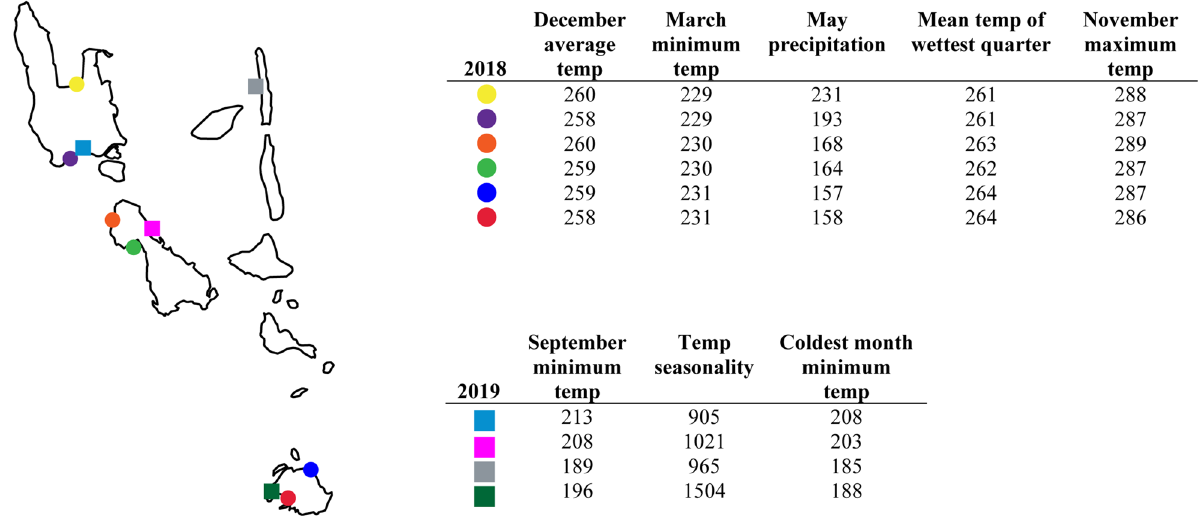
Figure 4. Values for the top contributing factors at each location (temperature values given in °C * 10 and precipitation values give in mm). The range of values within 2018 is minimal for each factor. There is a wider range in the values for each factor in 2019 (Vemaps.com, Adobe, San Jose, CA, USA).